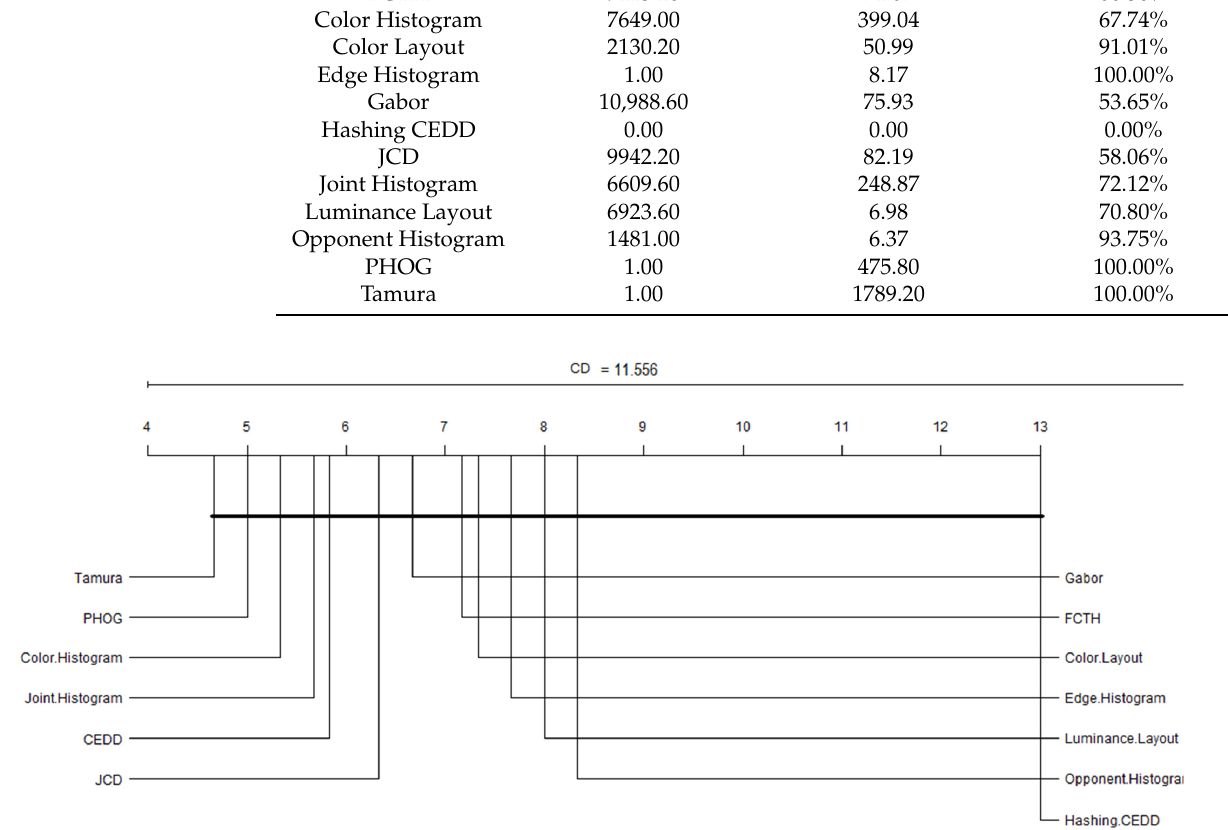
Figure 16. Critical Distance Diagram (CDD) for grayscale face images.